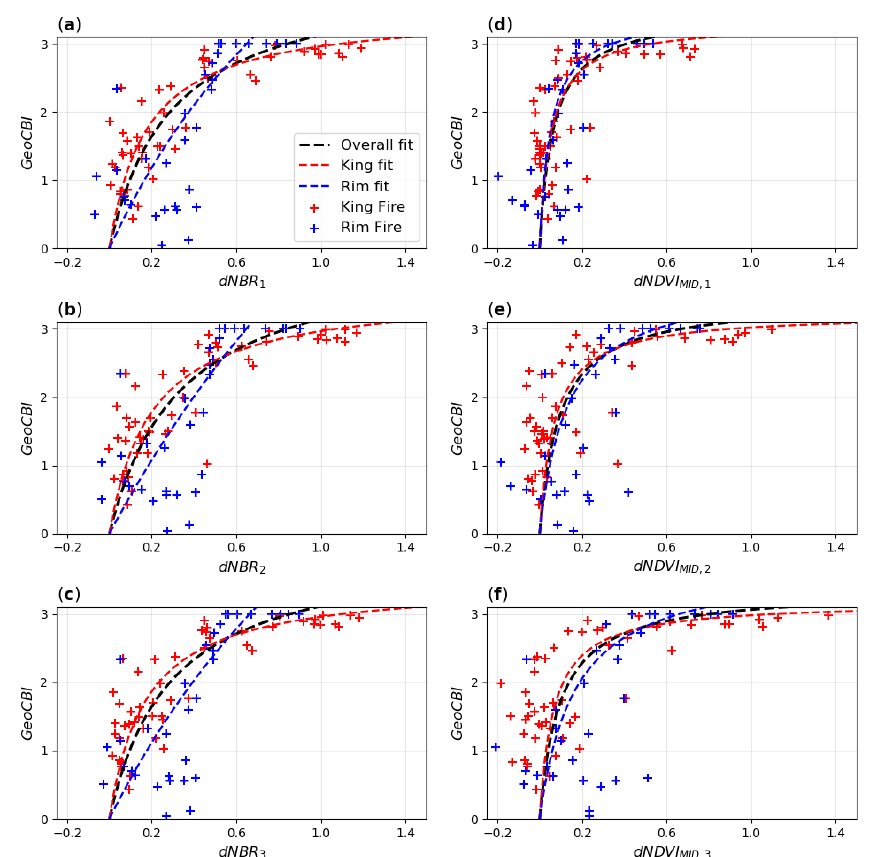
Figure 5. Scatter plots of GeoCBI field data from the Rim fire (blue) and King fire (red) with multiple regression lines corresponding to the overall data set (black), Rim fire (blue) and King fire (red). ( a ) GeoCBI-dNBR 1 ; ( b ) GeoCBI-dNBR 2 ; ( c ) GeoCBI-dNBR 3 ; ( d ) GeoCBI-dNDVI MID,1 ; ( e ) GeoCBI-dNDVI MID,2 ; ( f ) GeoCBI-dNDVI MID,3 .